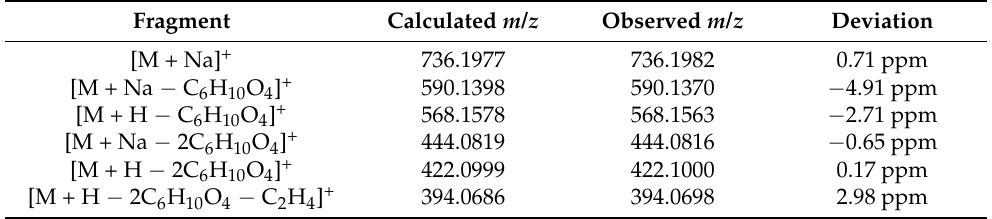
Table 6. The deviations between calculated and observed m / z values of each fragment derived from compound 6 .